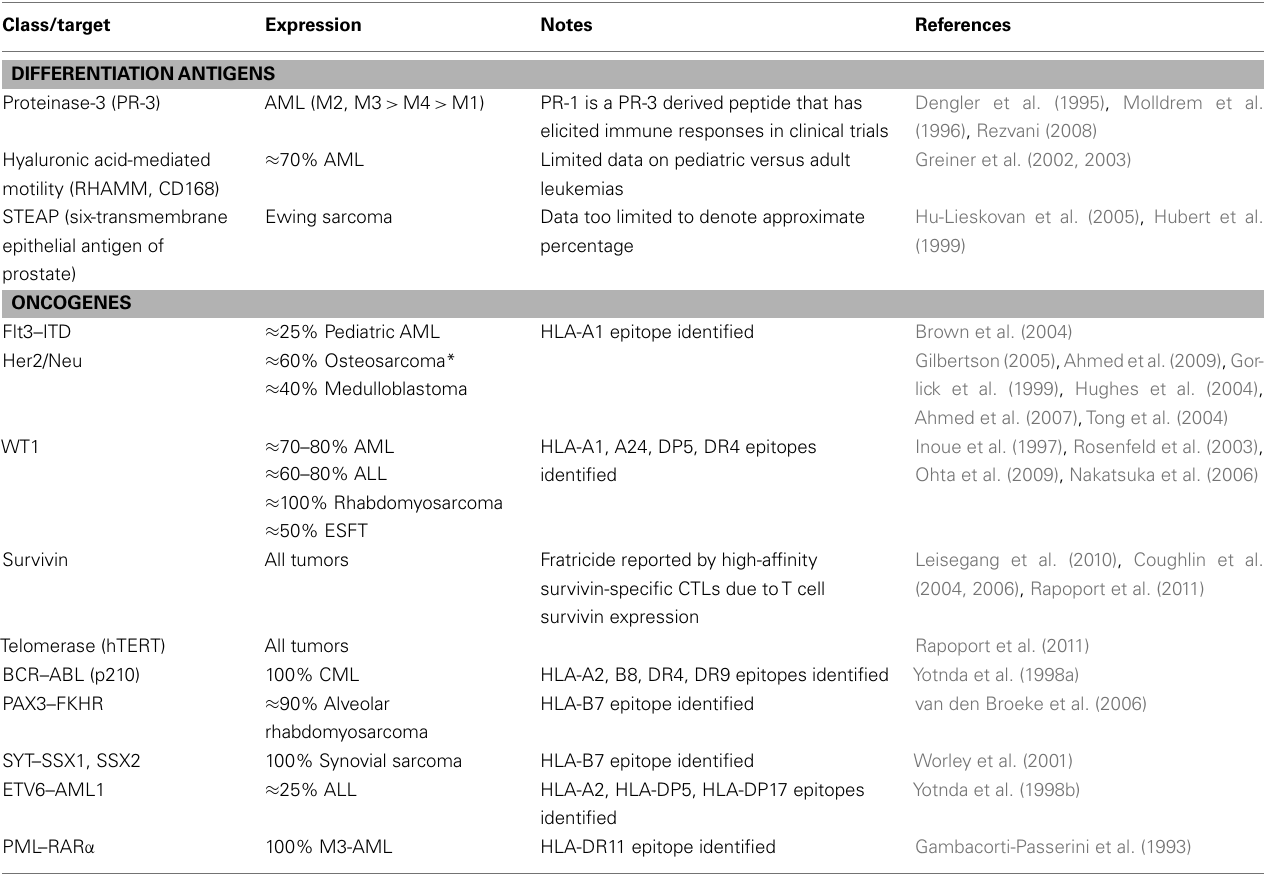
Table 2 | Non-CTA, MHC restricted immune targets expressed in pediatric